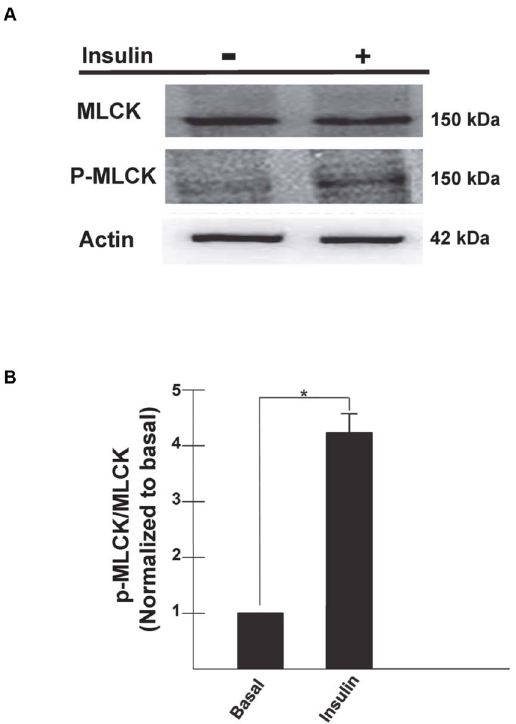
Figure 2. Insulin stimulates the phosphorylation of MLCK in 3T3-L1 adipocytes. 3T3-L1 adipocytes were serum starved for 4 h and then either left untreated or stimulated with insulin (100 nM) for 20 min. (A) Whole cell lysates were prepared, subjected to SDS-PAGE and then immunoblotted using antibodies against MLCK, P-MLCK, or actin. (B) Determination of band densities was measured using ImageQuant software and are presented as P-MLCK/MLCK and normalized to basal levels. Results are the mean 6 SEM of three independent experiments. *p , 0.05.